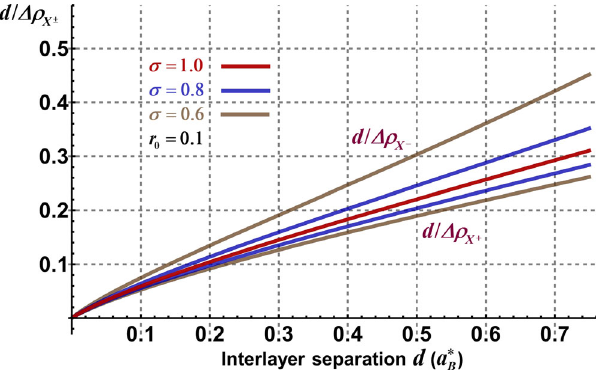
Fig. 6 Charged interlayer exciton size versus interlayer separation. The ratio of the interlayer separation d in a bilayer to the equilibrium center-of- mass-to-center-of-mass distance Δ ρ X ± of the two equivalent interlayer excitons (IEs) to form the charged interlayer exciton (CIE) due to the tunnel exchange coupling, as given by Eq. (4) for a typical set of parameters used in this